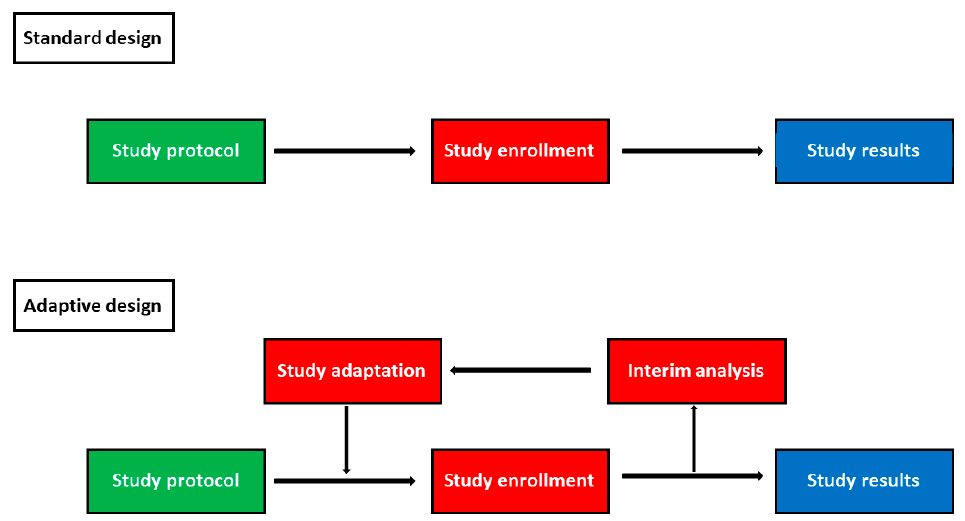
Figure 1. Comparison between standard and adaptive study designs.